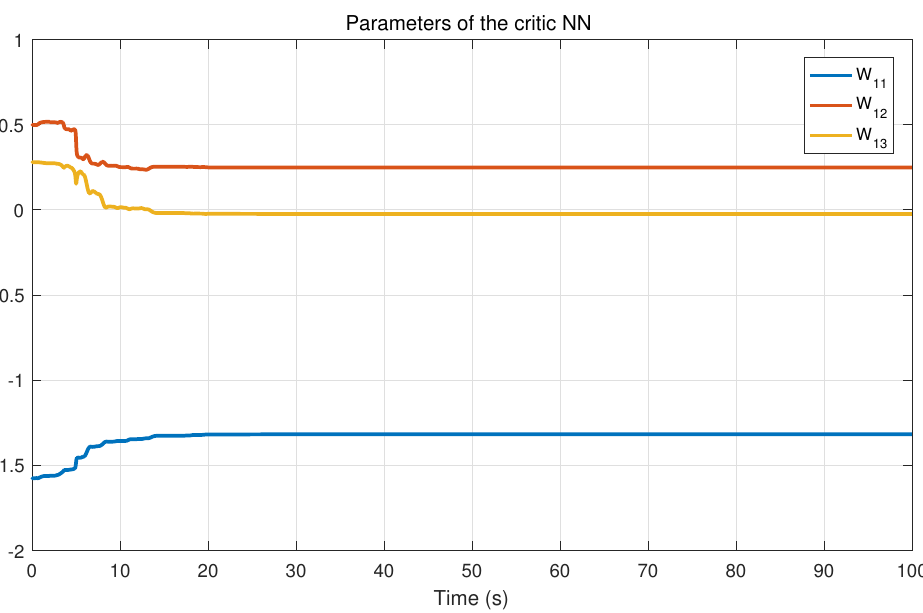
Figure 8. Evolution of the critic estimates for player